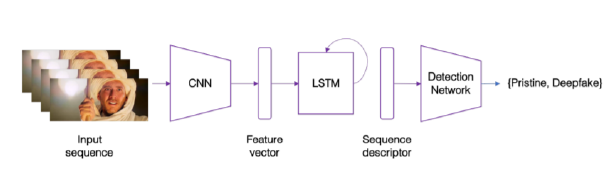
Fig 5. LSTM for Sequence Processing [9]